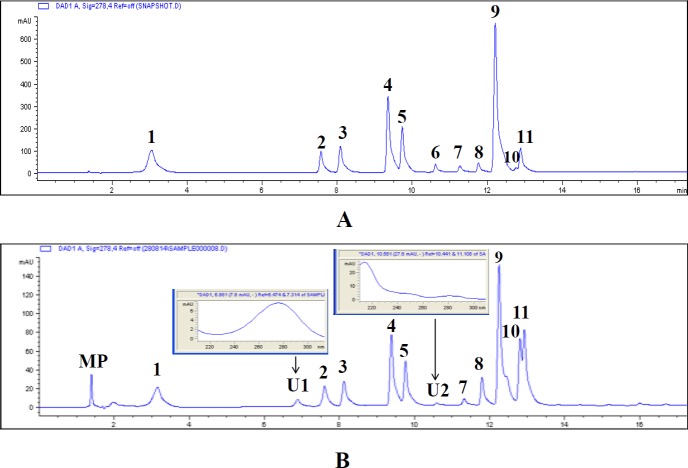
HPLC chromatogram of standards and phenol rich extract of Russula senecis (RusePre).(A) Standards each in 50 µg/ml concentration (peaks: 1, gallic acid; 2, chlorogenic acid; 3, vanillic acid; 4, p-coumaric acid; 5, ferulic acid; 6, myricetin; 7, salicylic acid; 8, quercetin; 9, cinnamic acid; 10, pyrogallol; 11, kaempferol) (B) Phenolic profile of RusePre with UV spectra of two unidentified peaks (inset) (MP, mobile phase; 1, gallic acid; U1, unidentified peak 1; 2, chlorogenic acid; 3, vanillic acid; 4, p-coumaric acid; 5, ferulic acid; U2, unidentified peak 2; 7, salicylic acid; 8, quercetin; 9, cinnamic acid; 10, pyrogallol; 11, kaempferol).